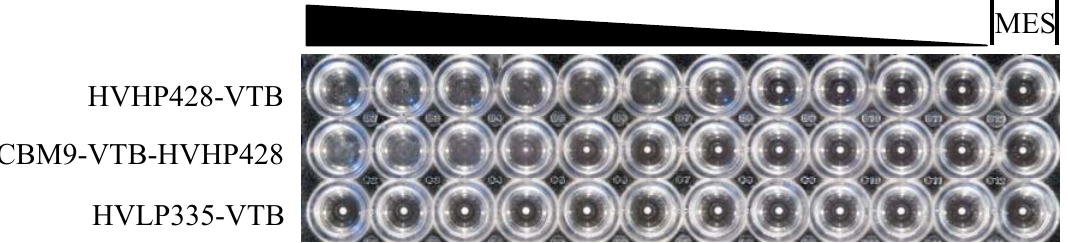
Figure 4. Functional characterization of CBM9-VTB-HVHP428. (A) Agglutination of S. aureus (wells without small white dots in the middle) was seen for CBM9-VTB-HVHP428 with an end limit of 150 nM compared to an end limit of 18.7 nM for the positive control, HVHP428-VTB. No agglutination was seen for the negative control, HVLP335-VTB [26]. (B) Binding of CBM9-VTB-HVHP428 to cellulose. Serial dilutions of purified CBM9-VTB- HVHP428 and HVHP428-VTB were applied to Whatman No. 5 filter paper using a vacuum manifold. Binding was detected by incubating the paper with alkaline phosphatase-labeled protein